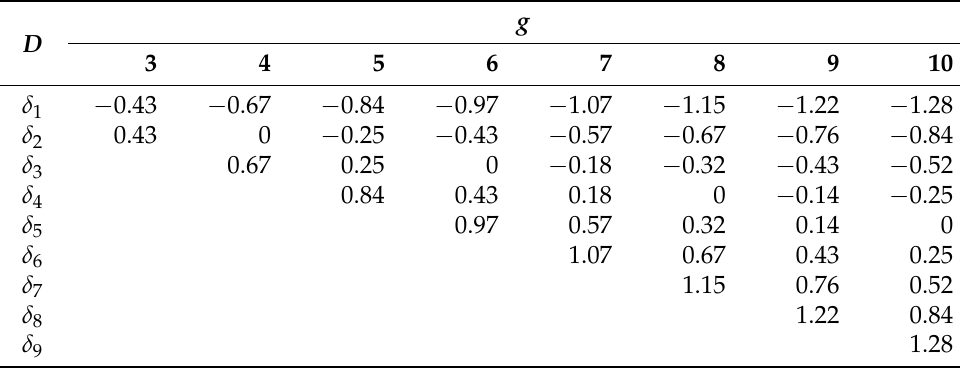
Table 2. The breakpoints for the N ( 0,1 ) distribution [52].